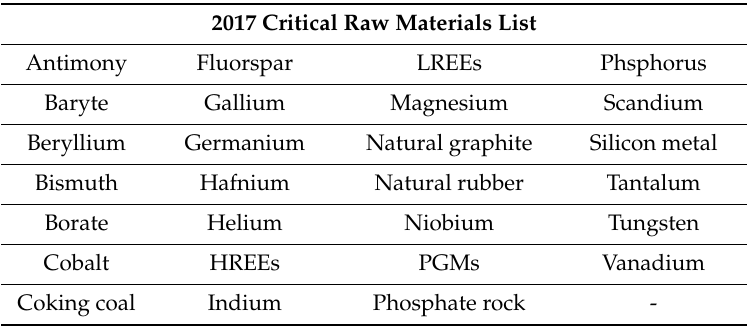
Table 2. Critical Raw Materials List defined by the EU Commission in